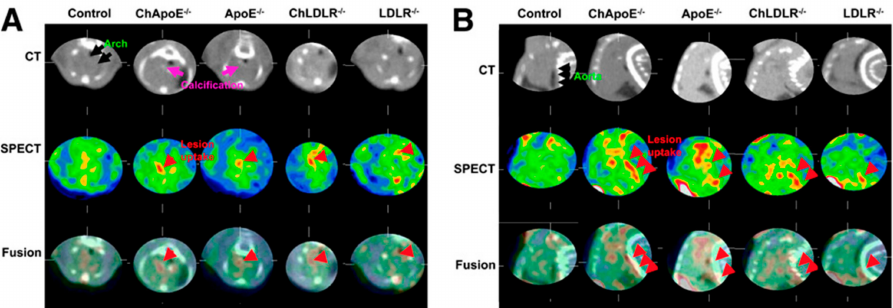
Figure 6. In vivo micro-SPECT / micro-CT transverse ( A ) and sagittal ( B ) zoomed and masked images of the 5 study groups. Compound [ 99m Tc] 58 uptake in atherosclerotic aortic lesions was identified noninvasively in arch and abdominal aorta by micro-SPECT aided by micro-CT; aortic arch calcification was detected by micro-CT. Ch 5 high-cholesterol-fed. Reprinted with permission from [97] copyright © 2009 by the Society of Nuclear Medicine, Inc.